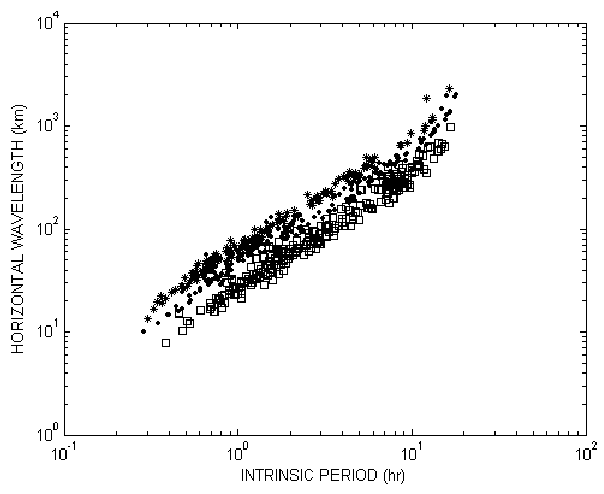
Fig.10 Horizontal wavelengths versus intrinsic periods of upward moving gravity Fig. 10. Horizontal wavelengths versus intrinsic periods of upward wave packets of winter data set. Wave packets obtained by window T2Z3, moving gravity wave packets of winter data set. Wave packets ob- T3aZ3, T3bZ3, T3cZ3 and T4Z3 were denoted by ‘square’ ; Wave packets tained by window T2Z3, T3aZ3, T3bZ3, T3cZ3 and T4Z3 were de- obtained by window T2Z4, T3aZ4, T3bZ4, T3cZ4 and T4Z4 were denoted by noted by square; Wave packets obtained by window T2Z4, T3aZ4, ‘dot’ ; Wave packets obtained by window T2Z5, T3aZ5, T3bZ5, T3cZ5 and T3bZ4, T3cZ4 and T4Z4 were denoted by dot; Wave packets ob- T4Z5 were denoted by ‘star’. tained by window T2Z5, T3aZ5, T3bZ5, T3cZ5 and T4Z5 were denoted by star.